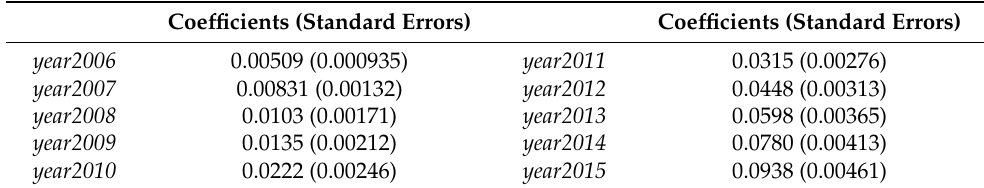
Table 4. Coefficients of the year fixed effect corresponding to the two-way fixed